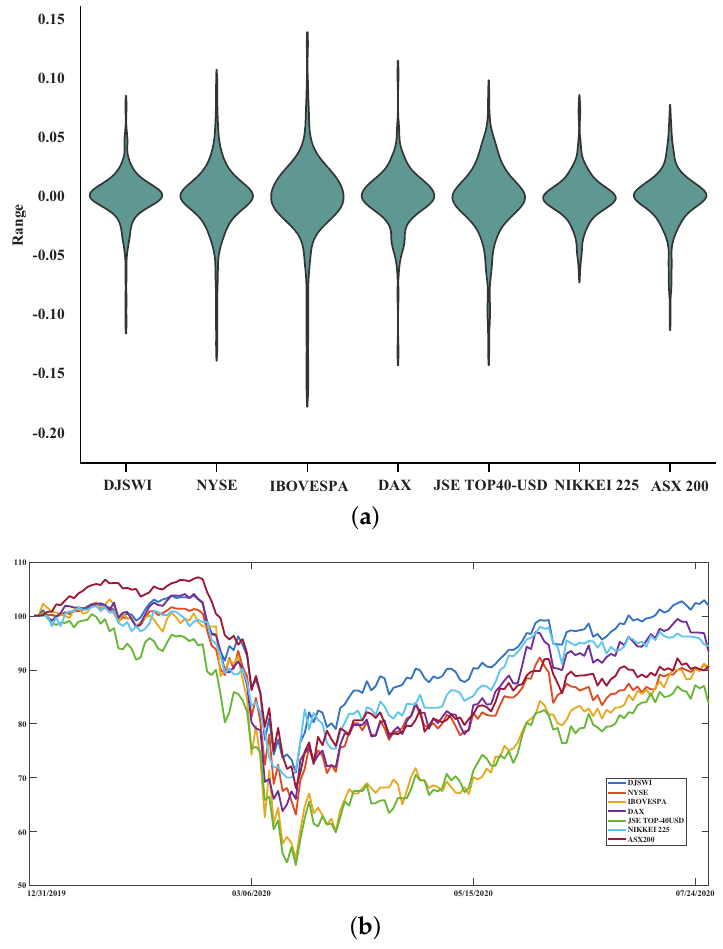
Figure 4. Joint comparison of the seven SMIs evaluated: ( a ) Probability densities of the analyzed stock indices returns (1 January–31 July 2020), ( b ) performance of the analyzed stock market indices (SMIs) over the time horizon 31 December 2019–31 July